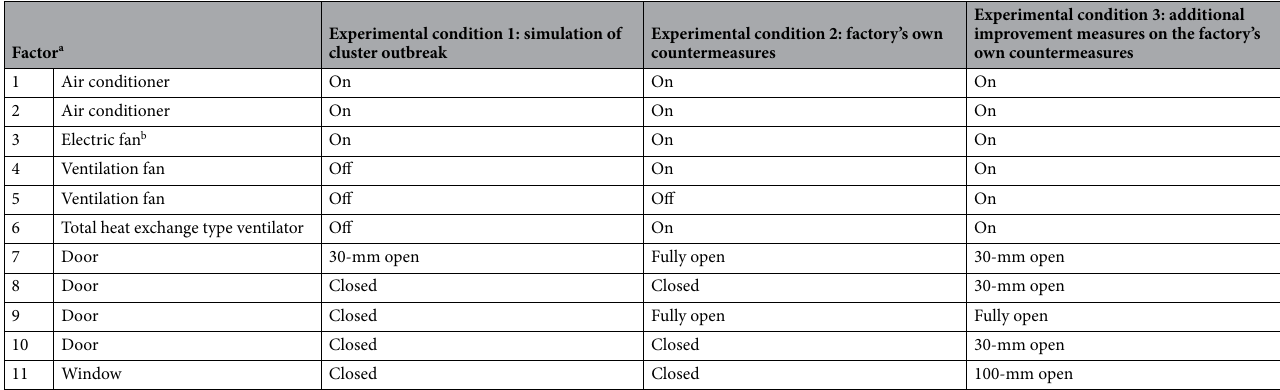
Table 1. Experimental conditions. a Factors 1 to 11 in the Table 1 were linked to 1 to 11 in Fig. 4. b Electric fans were placed in different locations in experimental condition 1 and experimental condition 2 and 3, as shown in Fig.